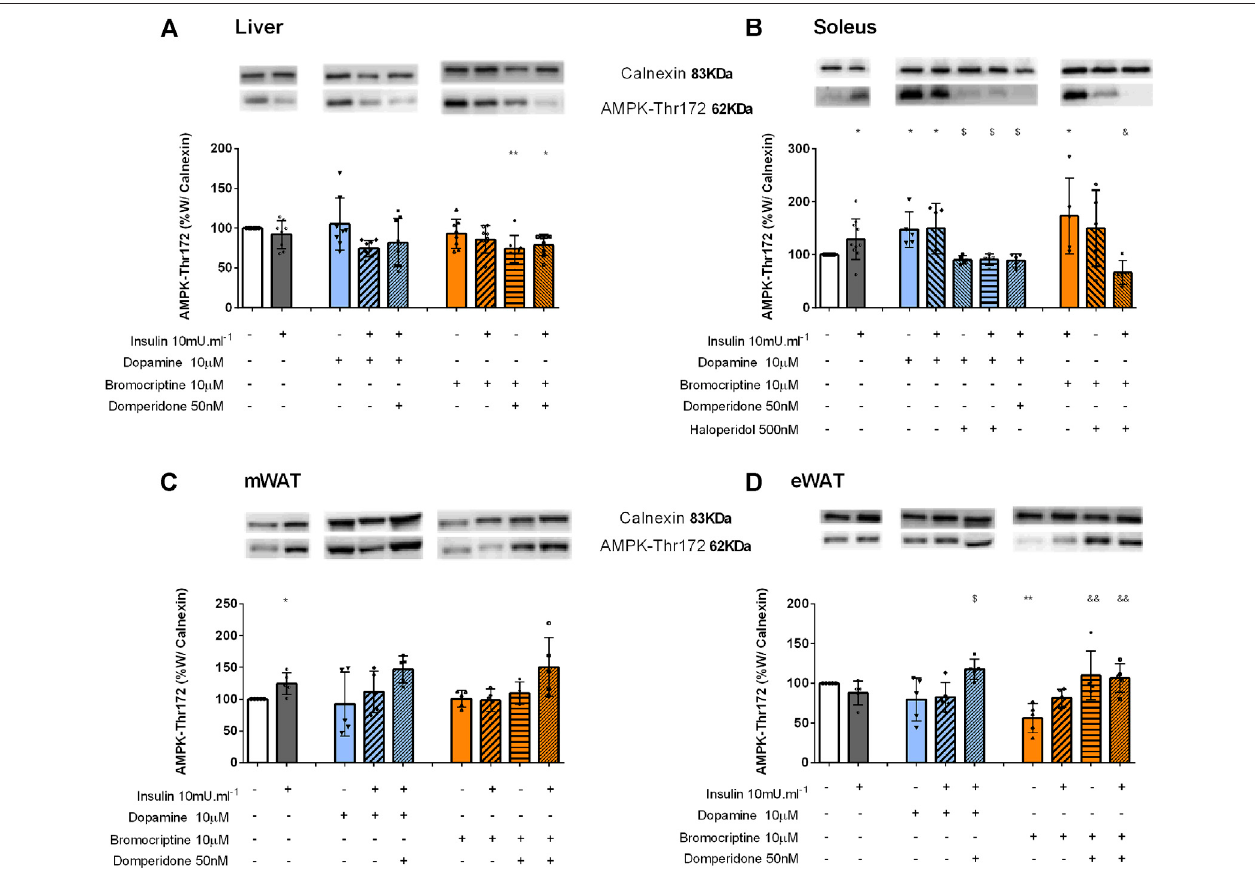
FIGURE5| InvolvementofdopamineandbromocriptineonAMPKphosphorylationintheliver (A) ,soleusmuscle (B) mWAT (C), andeWAT (D) .Effectofdopamine (10 μ M, blue bars) and bromocriptine (10 μ M, orange bars) on AMPK phosphorylation in the presence and absence of insulin (10m U ml − 1 ) and its blockade by domperidone, a D2R antagonist (50 nM) and/or haloperidol (500 nM), a D1R and D2R antagonist in the liver, soleus muscle, and mesenteric and epididymal adipose tissue.The top of fi guresshowsrepresentativeWesternblotsfortheeffectofdopamineandbromocriptineonAMPK-Thr172(62 kDaband)phosphorylation,inthe presence and absence ofinsulin, and its blockade bydomperidone and/or haloperidol. Calnexin wasused asthe loadingcontrol (83 kDa band). Bars represent mean ± SD. On the bottom of the bars are shown the different conditions used for each group tested with + meaning presence of that stimuli and – absence of it. One-way ANOVAwithDunnet ’ sposthoccomparisontest* vs .control;# vs .insulin;$ vs .dopamine;& vs .bromocriptine.Levelsofsigni fi cance:* p < 0.05;** p < 0.01;*** p < 0.001; **** p < 0.0001.mWAT,mesenteric whiteadipose tissue;eWAT,epididymal whiteadiposetissue;D1R,dopaminereceptortype1;andD2R, dopamine receptortype